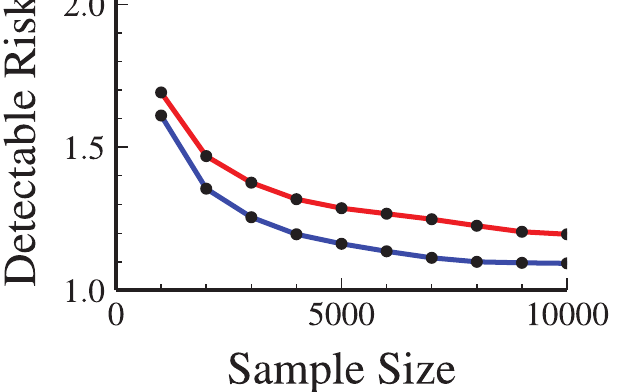
Figure 3. The Minimum Risk Detectable at 80% Power with p (cid:3) 0.05 after a Bonferroni Correction for Multiple Testing ( v 2 ‡ 28.5687) for Various Sample Sizes under Multiplicative (Red) and Additive (Blue) Models Power is calculated as the ability to detect a single common risk allele in the HapMap data in a whole genome association study within CEU samples.